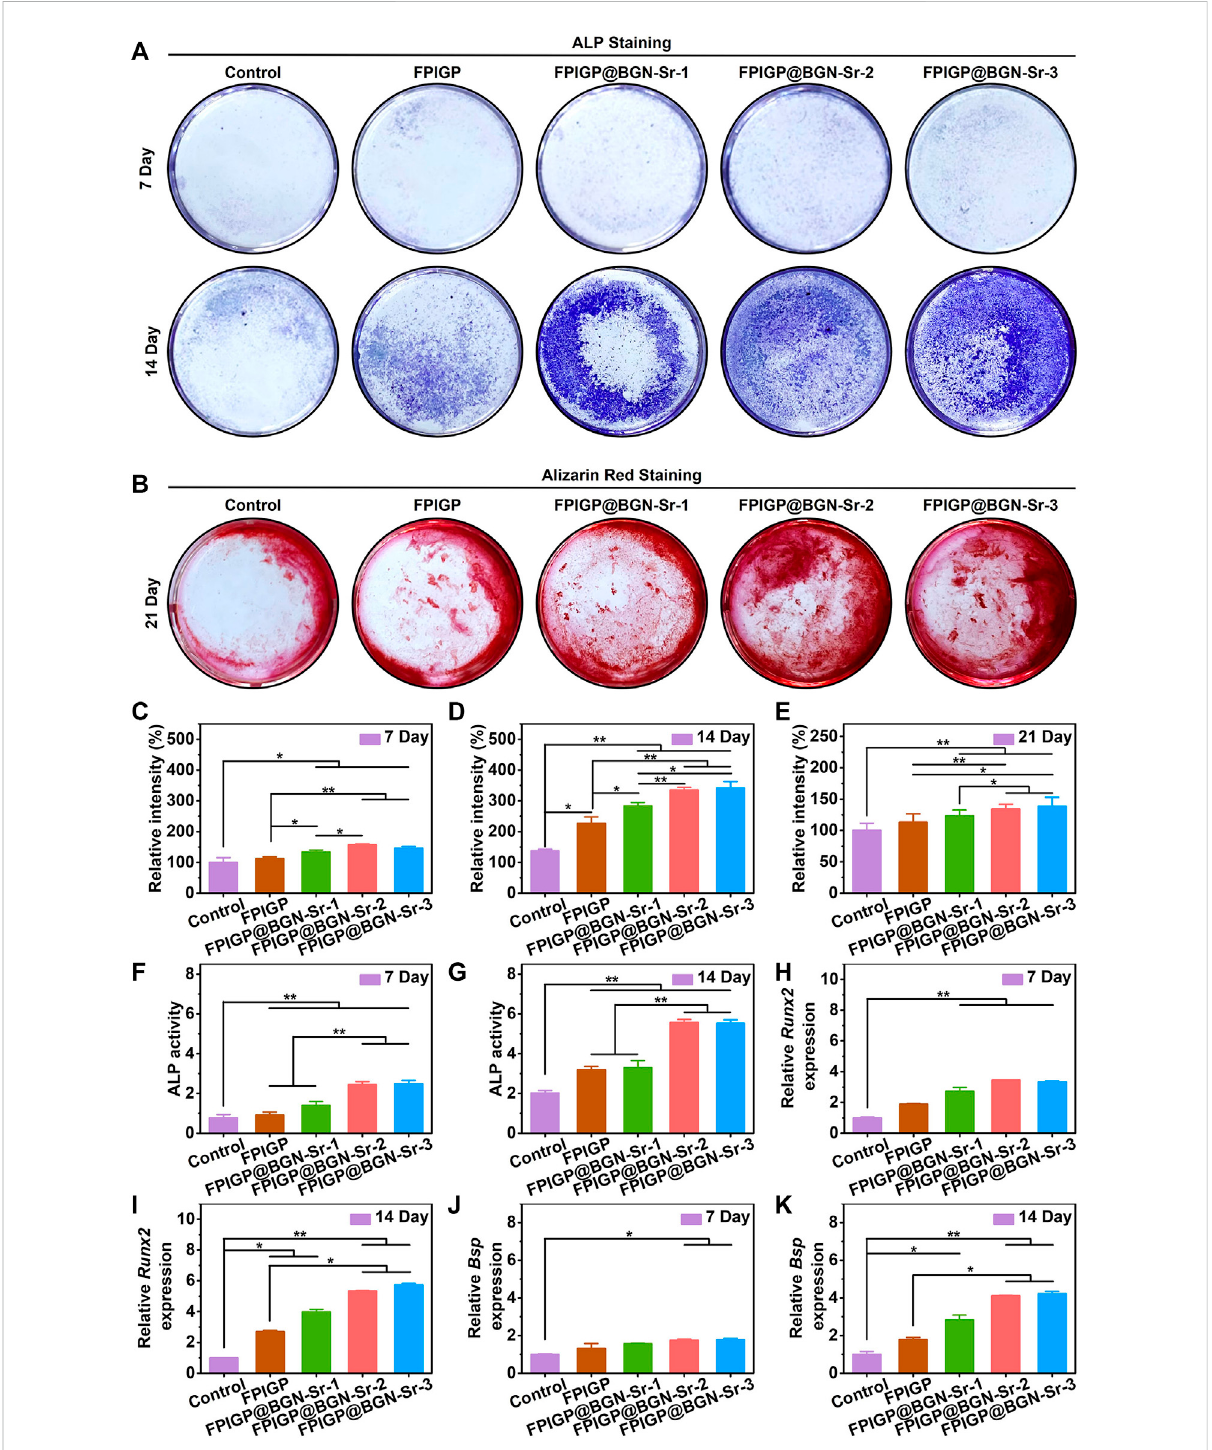
FIGURE 5 Osteogenic differentiation of C3H10T1/2 cells. (A) The ALP staining after incubation with hydrogels for 7 days and 14 days. (B) The alizarin red staining after incubation with hydrogels for 21 days. (C , D) The relative intensity based on ALP staining images of (C) 7 days and (D) 14 days. (E) The relative intensity based on alizarin red staining images of 21 days. (F , G) The ALP activity after incubation with hydrogels for (F) 7 days and (G) 14 days. (H , I) The relative Runx2 expression after incubation with hydrogels for (H) 7 days and (I) 14 days. (J , K) The relative Bsp expression after incubation with hydrogels for (J) 7 days and (K) 14